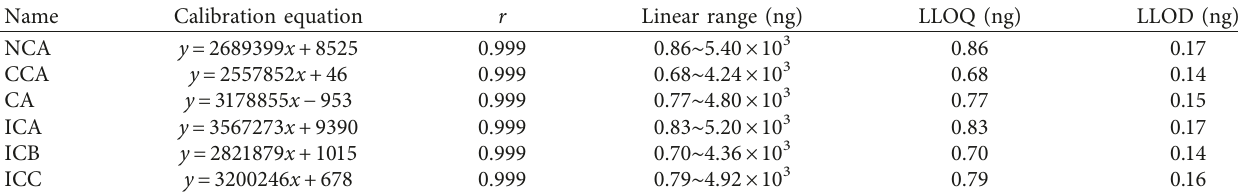
Table 2: Linear ranges, LLOD, LLOQ, and characteristic parameters of calibration curves.